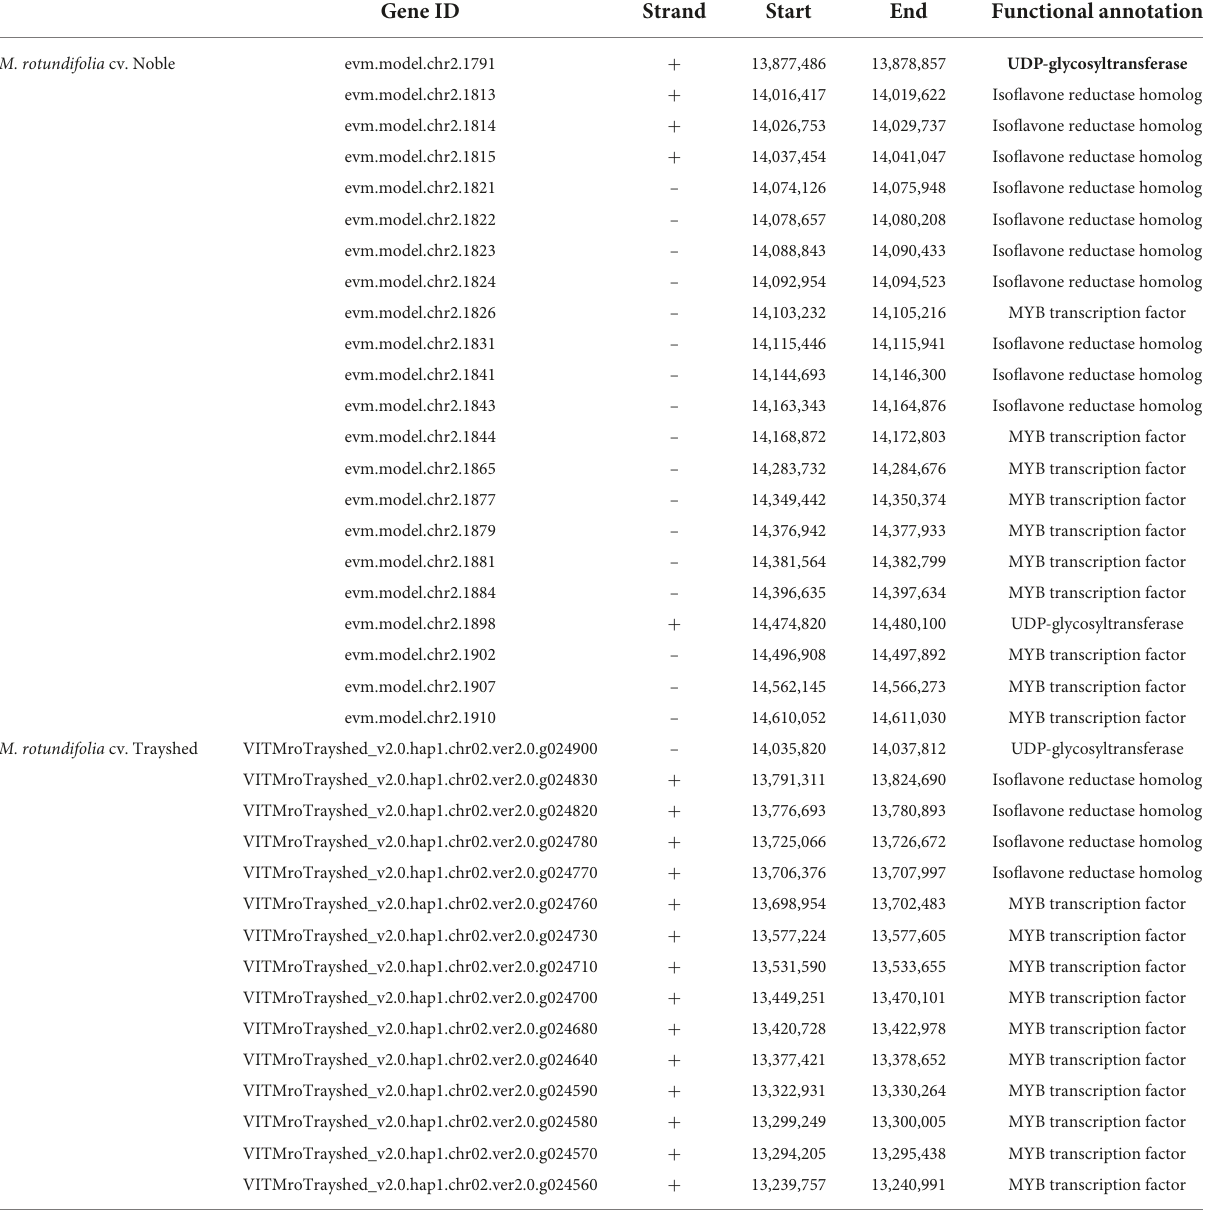
TABLE 3 Paralogs of UDP-glycosyltransferase and isoflavone reductase homolog co-located with the chr2_14464718 QTN in the Noble genome and their homologs in the collinear region of the Trayshed genome. Gene ID Strand